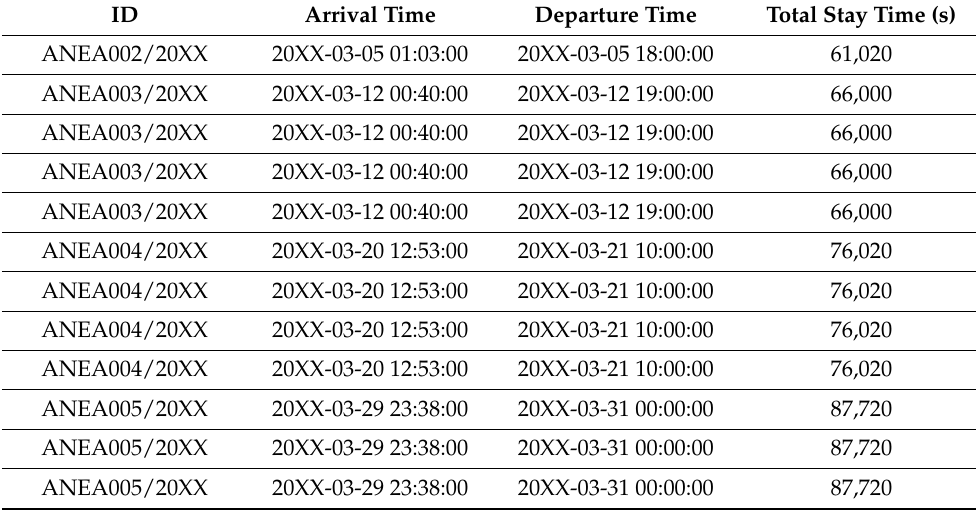
Table 1. Sample of input data showing each vehicle’s total stay time in the port .